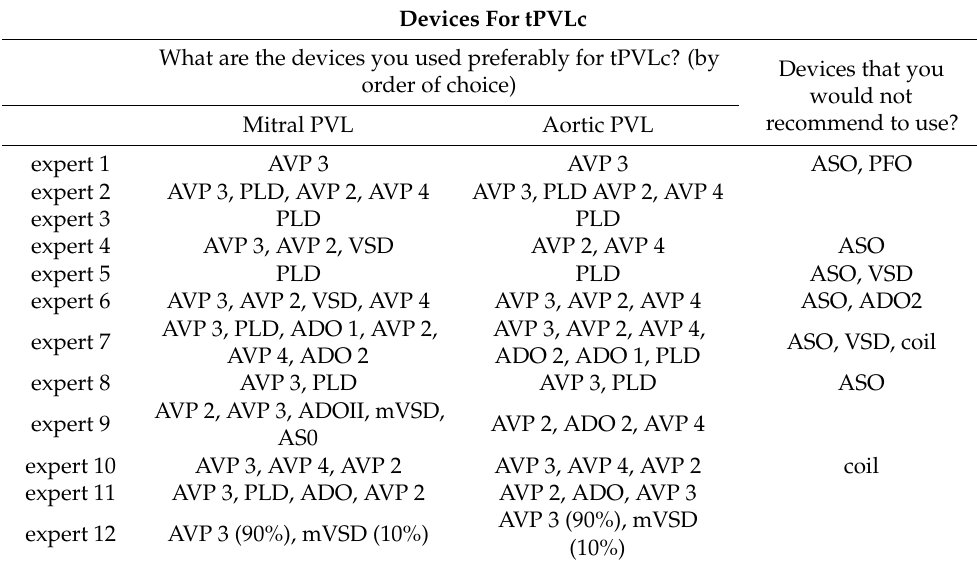
Table 10. The devices for tPVLc. AVP: Amplatzer Vascular Plug. Devices For